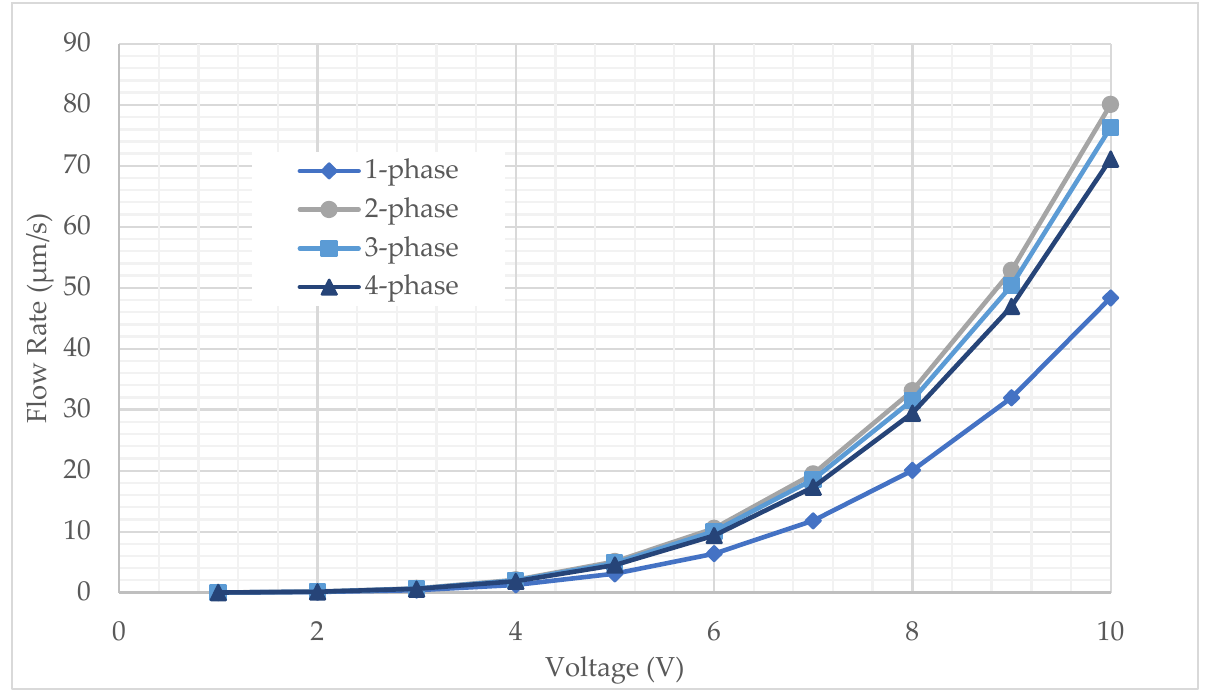
Figure 2. Flow rates for 1-, 2-, 3- and 4-phase configurations at 100 kHz. The voltage given is the peak voltage used in simulations.